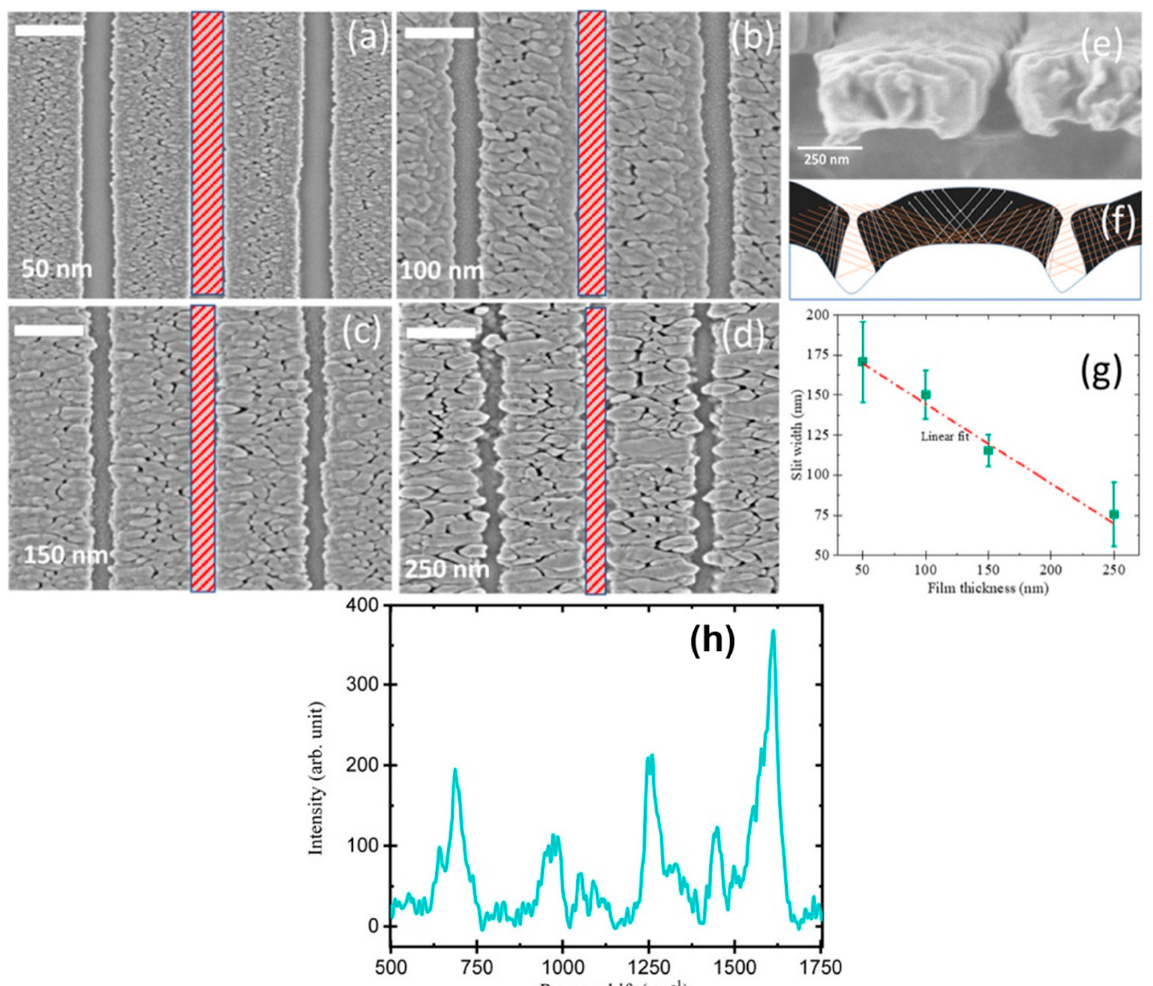
Figure 5. SEM images of Ag nanoslit substrates (top view) with thicknesses of ( a ) 50 nm, ( b ) 100 nm, ( c ) 150 nm, and ( d ) 250 nm. ( e ) Cross-sectional view of 100 nm thickness. ( f ) Net thickness of the film deposited at different substrate points (black region) with orange dotted lines showing incident flux direction and gray arrows showing columnar growth direction. ( g ) Plot of slit width vs. film thickness with a scale bar of 250 nm. ( h ) SERS spectra of 0.06 mg/mL bilirubin over Ag nanoslit substrate corresponding to 100 nm thickness. Reproduced with permission from [87].